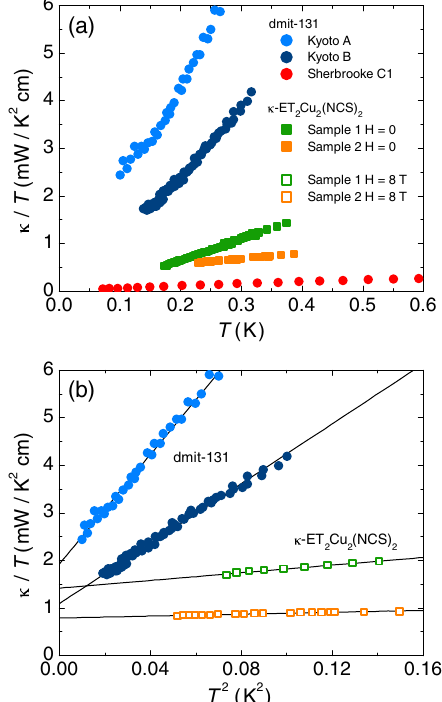
FIG. 8. (a) Thermal conductivity κ =T vs T for dmit-131 (dots) as measured by the Kyoto group and at Sherbrooke, and for κ -ET ð NCS Þ 2 Cu 2 2 (squares) as reported in Ref. [23]. All data are in H ¼ 0 , meaning that κ -ET 2 Cu 2 ð NCS Þ 2 is in the superconduct- ing state (full squares) where low-energy excitations are gapped and cannot scatter phonons. (b) Thermal conductivity κ =T vs T 2 for Kyoto dmit-131 data and κ -ET 2 Cu 2 ð NCS Þ 2 in its nonsuper- conducting state in H ¼ 8 T (open squares), which reveals a comparable residual linear term but a much smaller phonon slope in κ -ET 2 Cu 2 ð NCS Þ 2 . The lines are a fit of the data to κ =T ¼ a þ bT 2